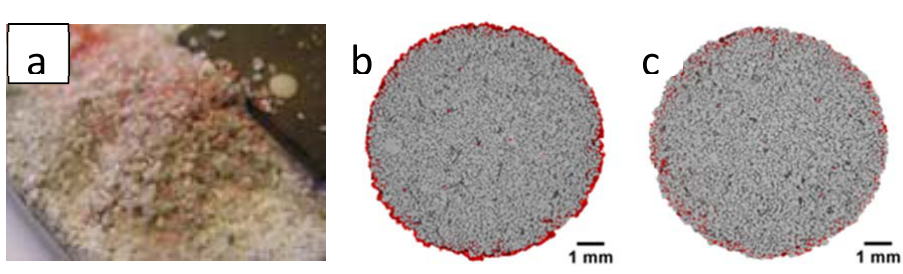
Figure 4 . Illustration of the formation of granular disintegration (a) from [59] and of the displacement of sodium chloride as a result of cycles of humidifying at 92% RH and drying at 10% RH [62]. b) shows a micro CT image of a sample impregnated with a NaCl solution and dried once, while c) shows the same sample after 3 cycles. The red color shows the NaCl and its displacement from outside the sample to its subsurface. Reproduced with authorization from [59] and